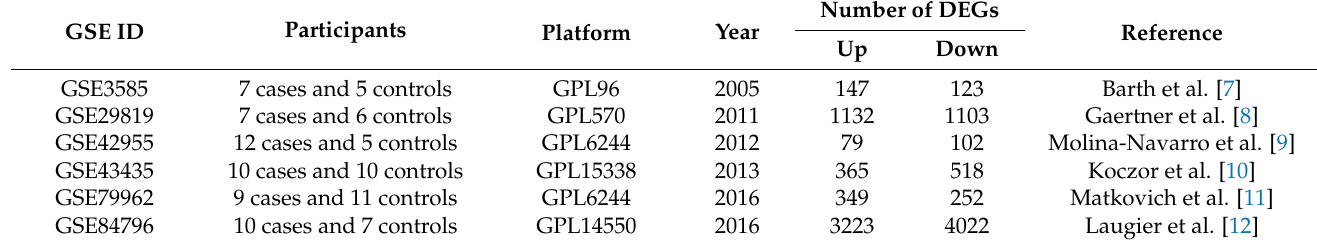
Table 1. Details of microarray analysis.